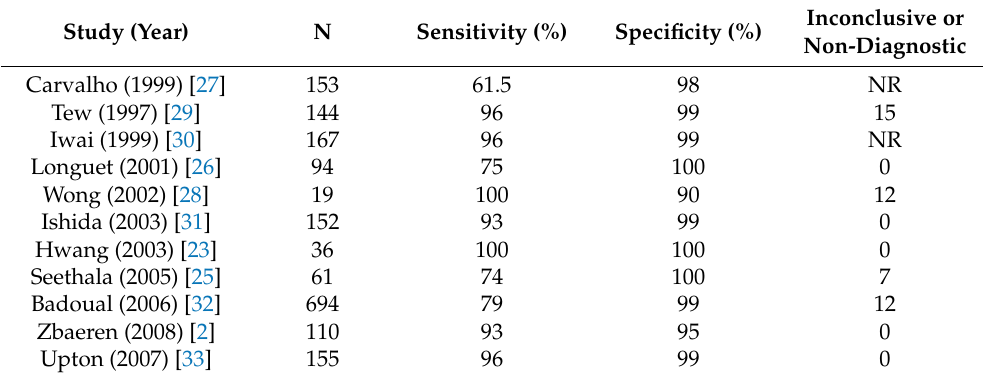
Table 3. Relevant literature reports with data on frozen section of parotid gland tumours (NR: not